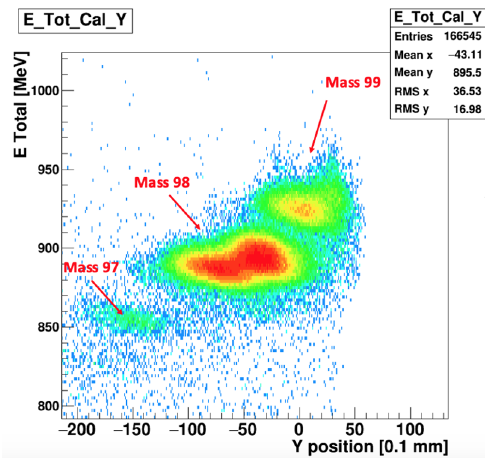
Figure 2. Particle identification spectrum of the total energy de- posited in the Si detectors versus the Y-position on the MARS focal plane. Di ff erent isotopes including mass 99 are clearly vis- ible and well